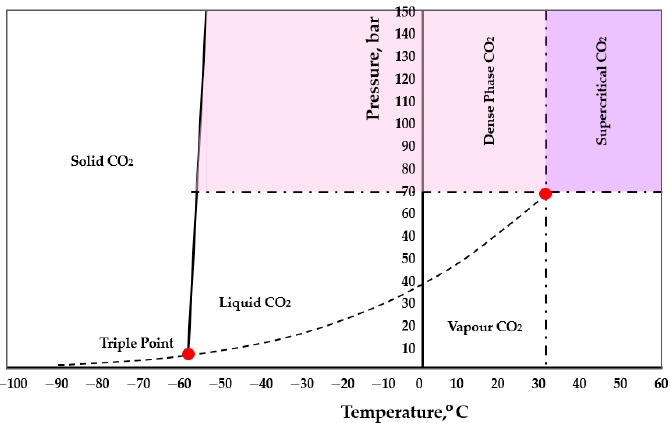
Figure 1. Phase diagram of pure CO 2 (modified after [63]).